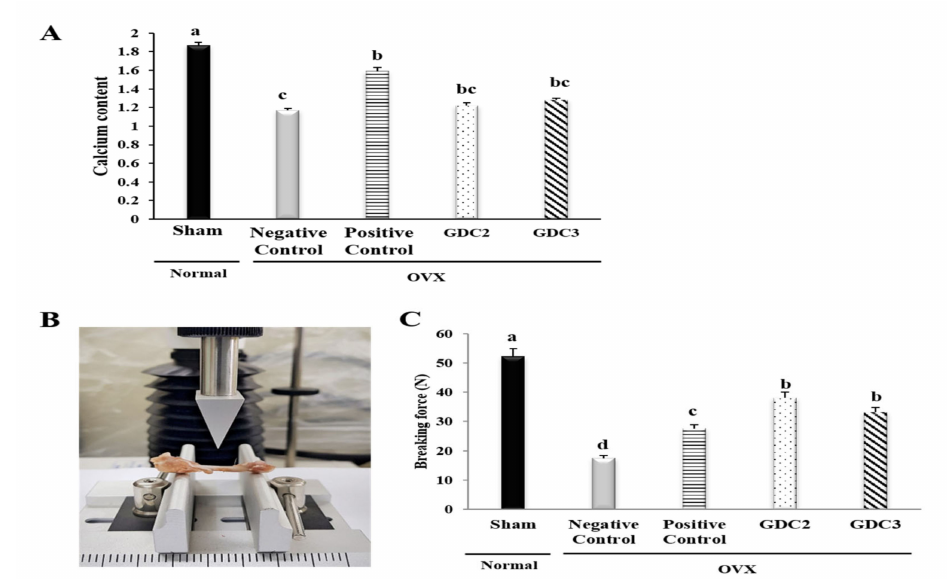
Figure 4. Calcium content and breaking force analysis of rat tibias. ( A ) Calcium content of rat tibias ( B ) Breaking force measurement via a texture analysis. ( C ) Breaking forces required for rat tibias. GDC2, Yeonsan Ogye flesh collagen extract (GD collagen) 2 g / Kg; GDC3, Yeonsan Ogye flesh collagen extract (GD collagen) 3 g / Kg. Values represent the mean ± standard deviation. Values with di ff erent letters di ff ered significantly using Duncan’s multiple range test ( p <